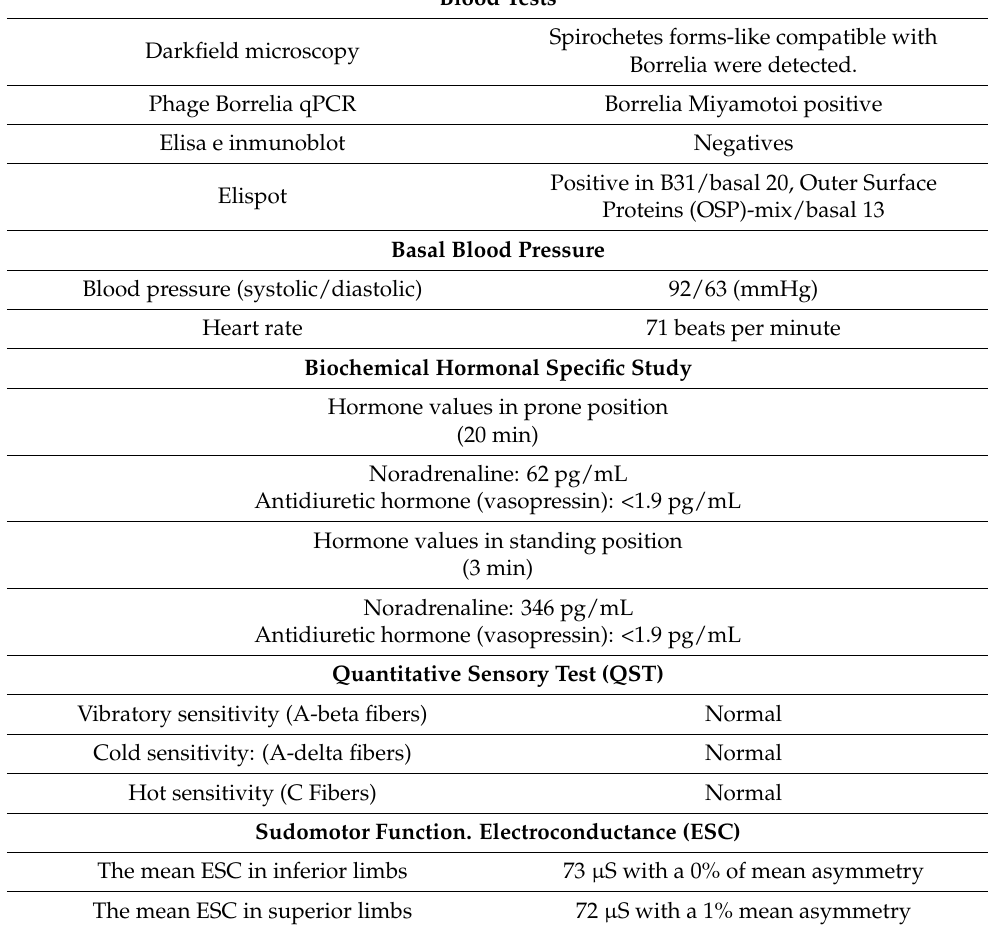
Table 1. Blood tests, hormonal study, sensory test, and electro conductance